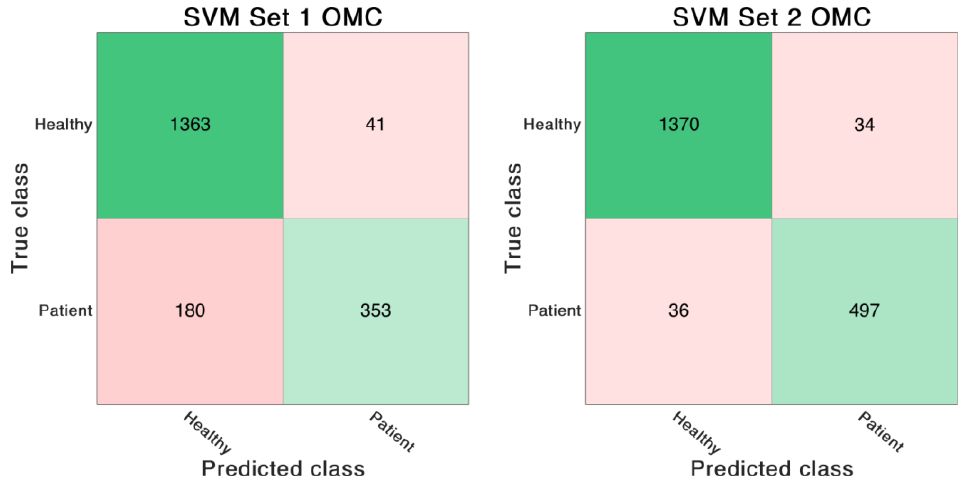
Figure 5. Confusion matrices of the SVM trained on OMC-based feature Set 1 and 2. The numbers in the matrices indicate correctly or incorrectly classified GC.